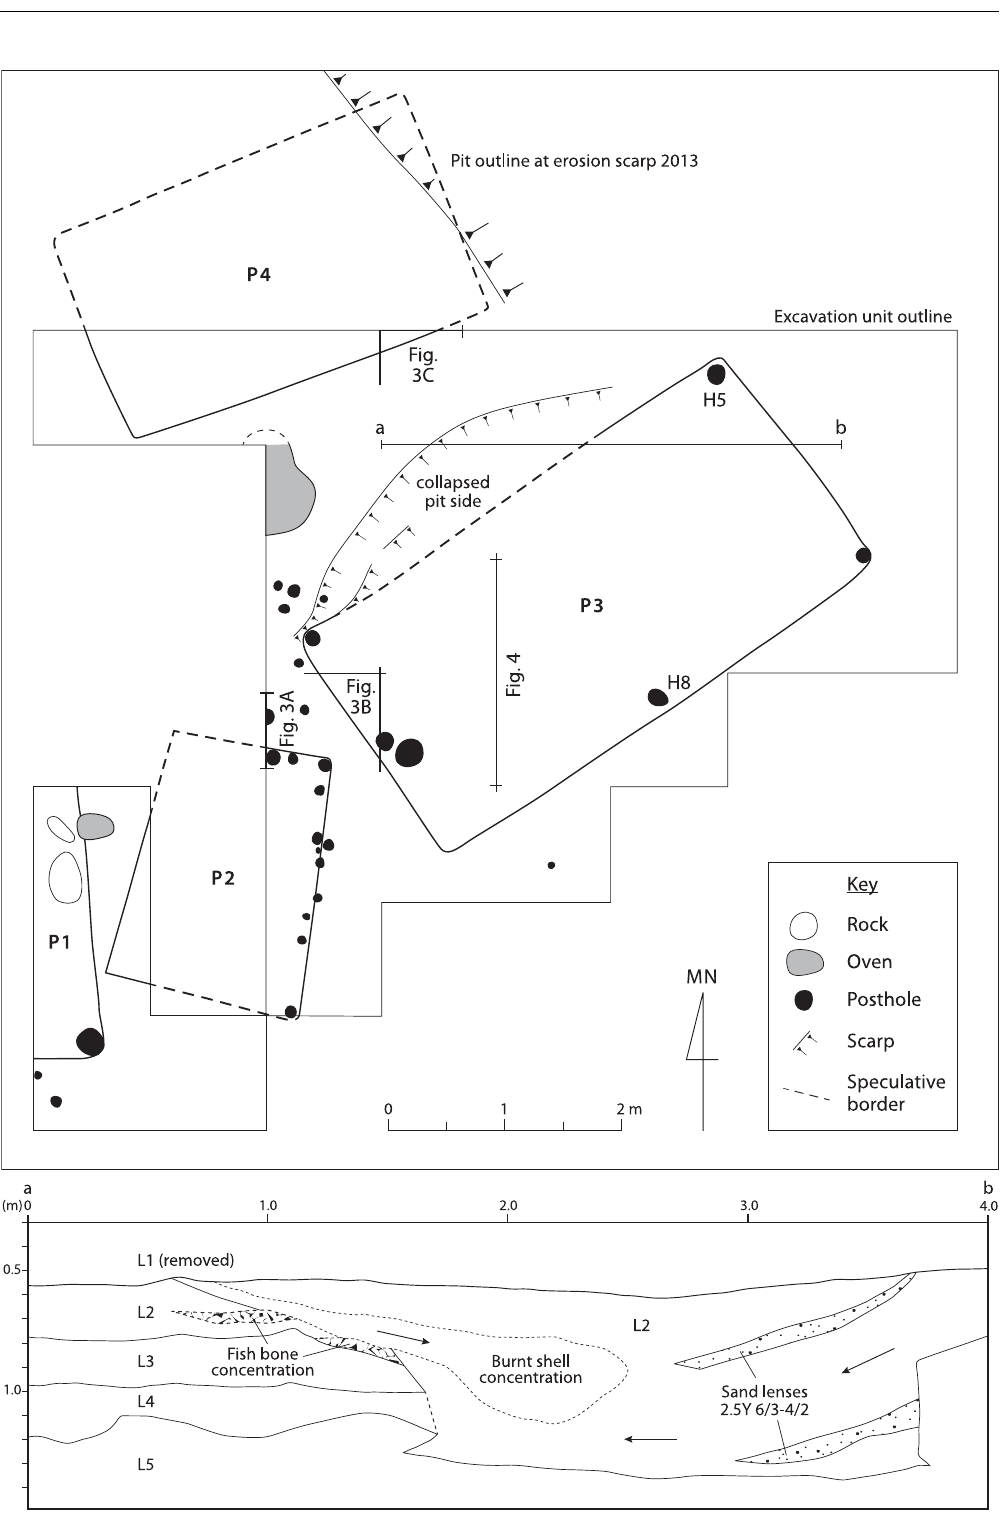
Fig 2. Excavation plan for I44/21 S pit structures. Pits coded P1-P4 (in bold, codes cross-referenced to Fig 1) are interpreted as subsurface components of semi-subterranean stores. All postholes recorded from the greater I44/21 S excavation area are represented. In P3, postholes from units H5 and H8 incorporating discrete starch-bearing fill are coded individually. The wall collapse along northern P3 side is an archaeological event capped by L2. Coded P3 excavation sections reference Figs 3 and 4; see also Figs 1 and S1 for further context, and S1 Table for unit